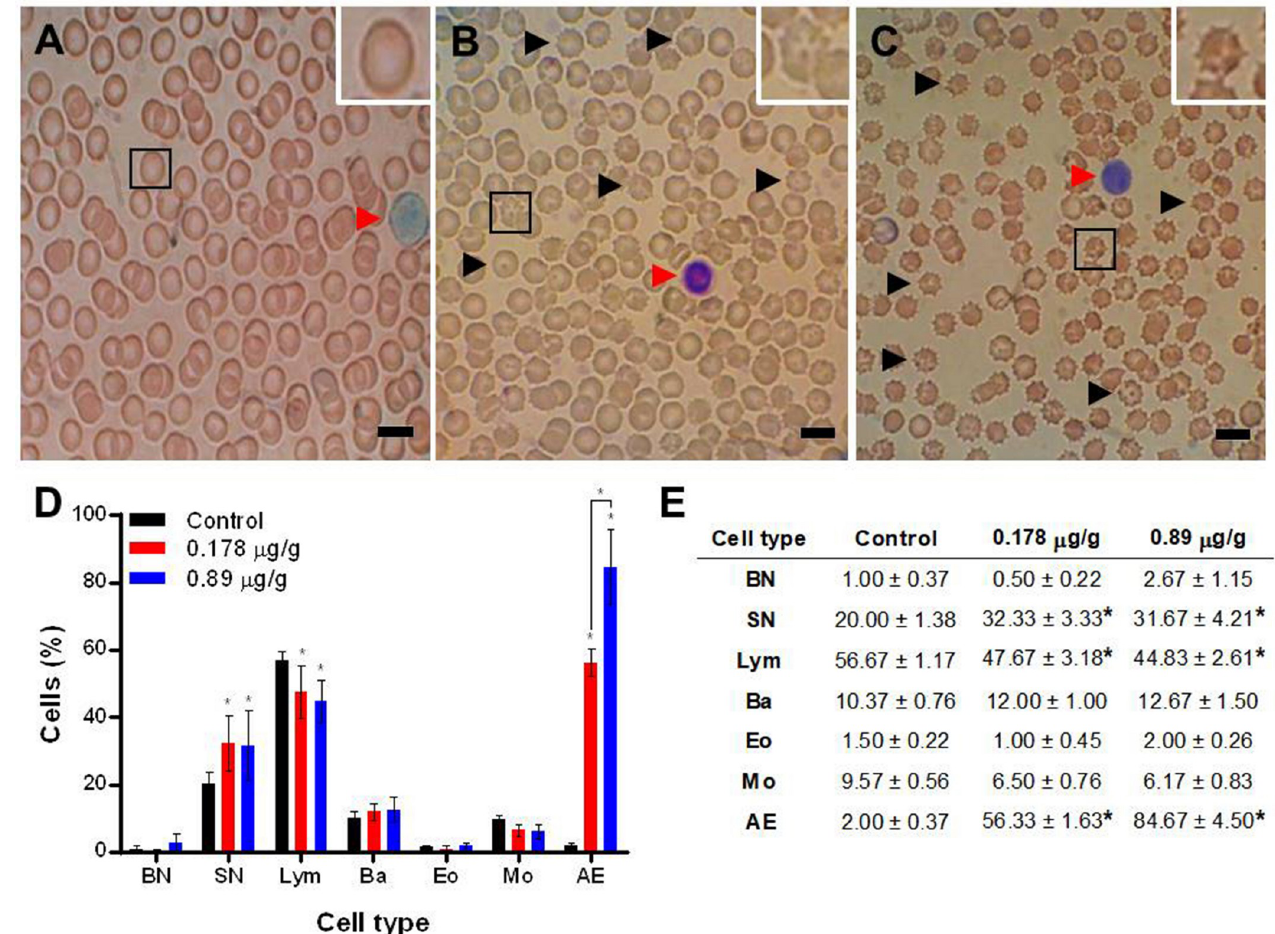
Fig 2. Blood films examination from rats treated with LAv. (A) Control treatment blood film; (B) 0.178 μ g/g LAv treatment blood film; (C) 0.89 μ g/g LAv treatment blood film; (D and E) quantification of the effect of LAv on erythrocytes (denoted as abnormal erythrocytes, AE) and leukocytes: band neutrophils (BN), segmented neutrophils (SN), lymphocytes (Lym), basophils (Ba), eosinophils (Eo) and monocytes (Mo). Black arrow heads indicate formation of acanthocytes and red arrow head indicates Lym presence, scale bars = 10 μ m (A, B and C). Asterisks denote statistical differences (P < 0.05) in contrast to the control (D and